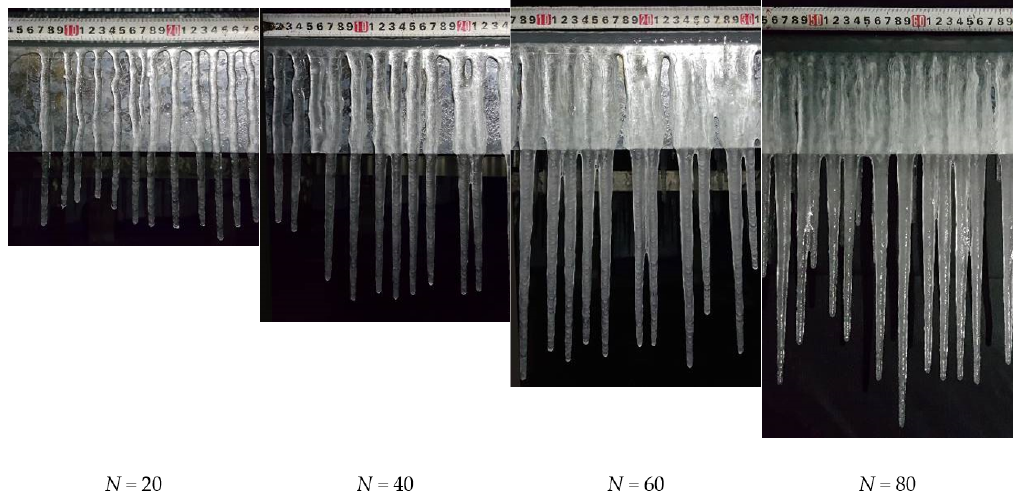
Figure 19. Side views of ice accretions for L100 and γ = 90°.